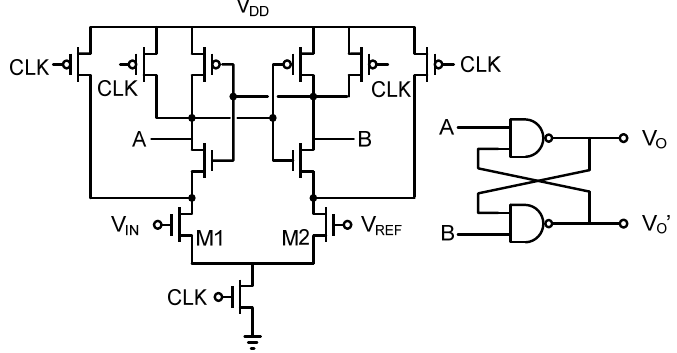
Figure 5. A successive approximation register (SAR) analog–digital converter (ADC) circuit schematic.